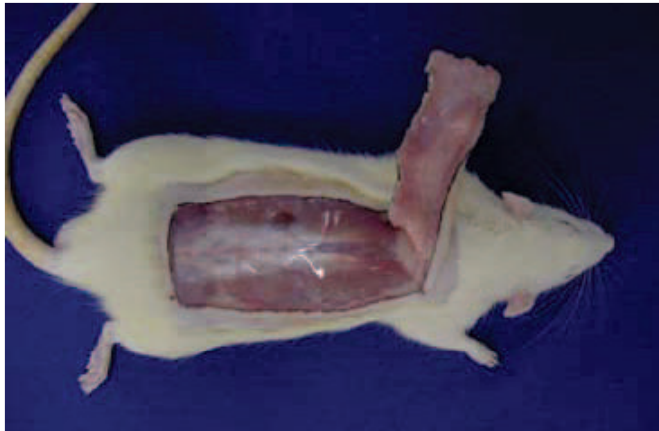
FIGURE 2 - Skin flap elevation and positioning of plastic barrier F1.